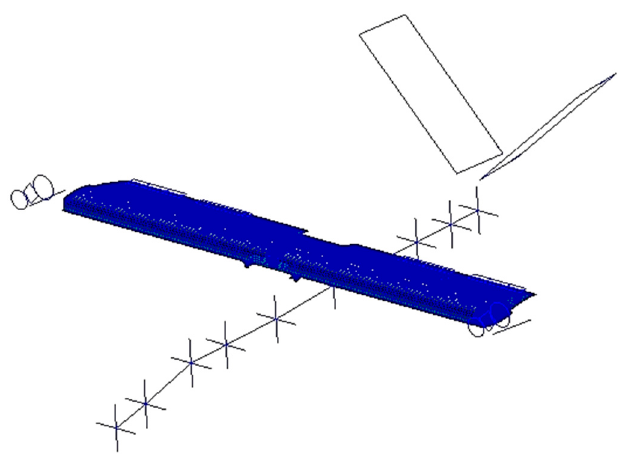
Figure 2. Dynamic model.